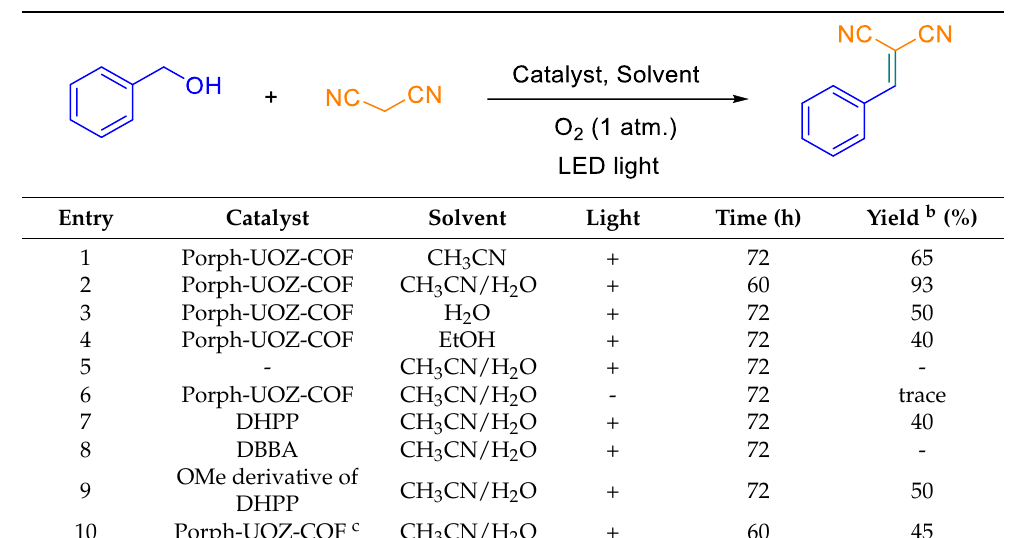
Table 1. Optimization conditions for the one-pot tandem synthesis of α , β -unsaturated nitrile a .